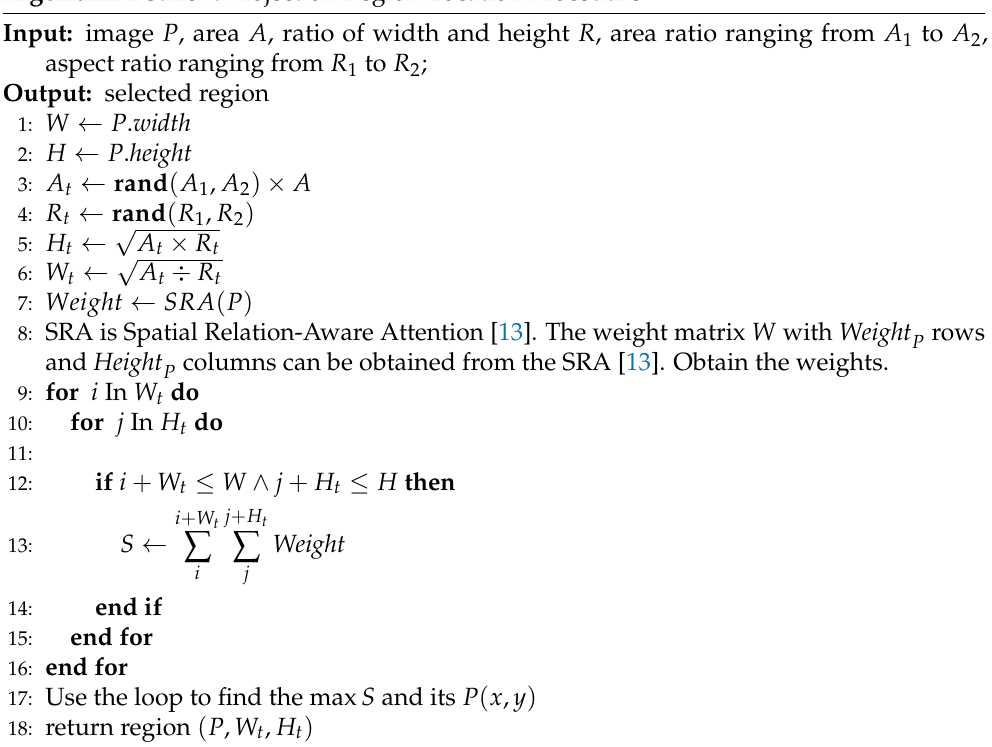
Algorithm 1 Salient Projection Region Location